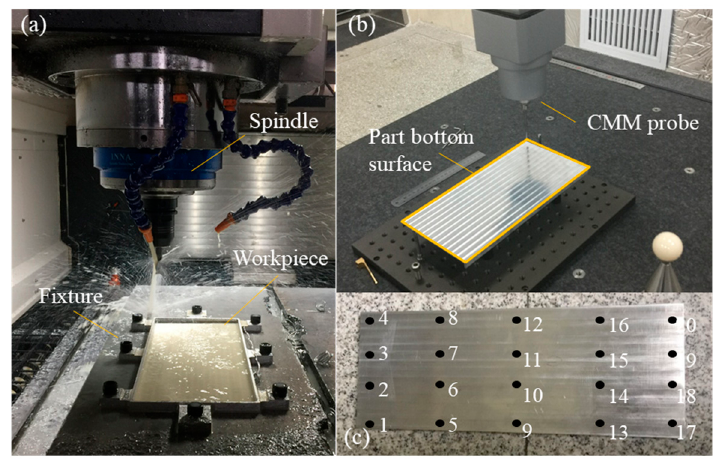
Figure 7. Experiment and measurement setup. ( a ) Milling of Part 4. ( b ) CMM measurement. ( c ) The measurement points.